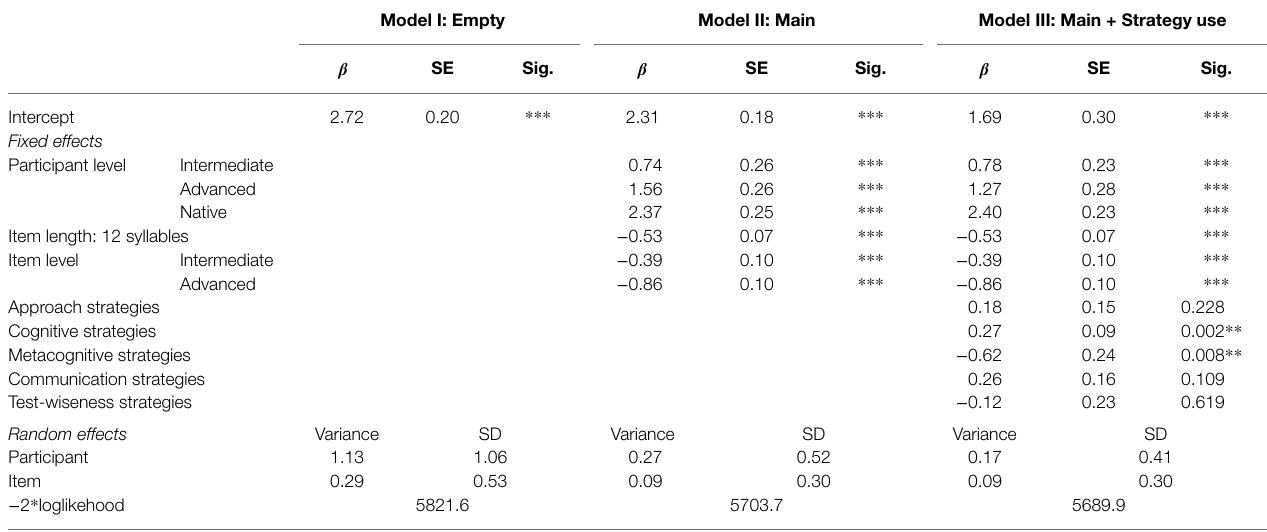
TABLE 4 | Statistics for the linear mixed-effects models: Models I, II, and